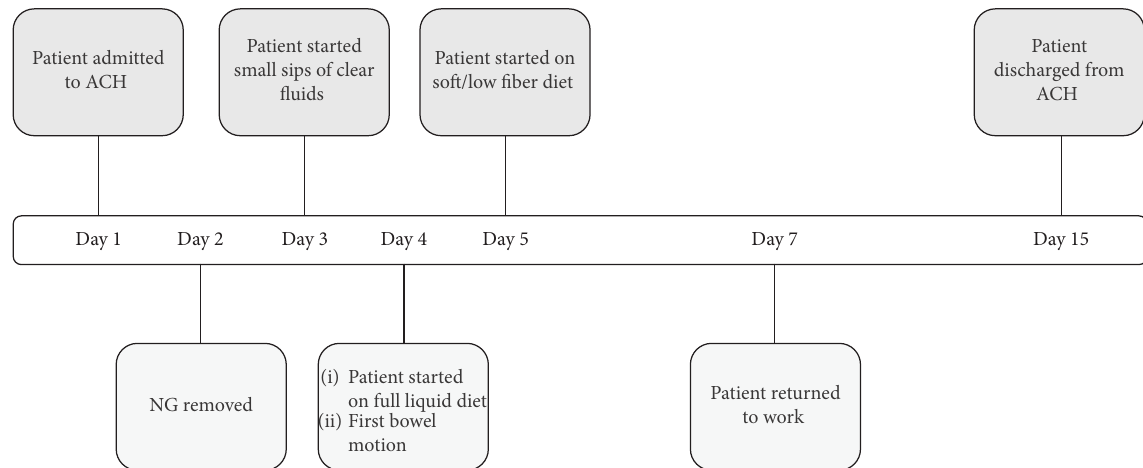
Figure 2: Timeline showing 5 days in the acute phase of inpatient-equivalent care and 10 days in the restorative phase of postacute recovery